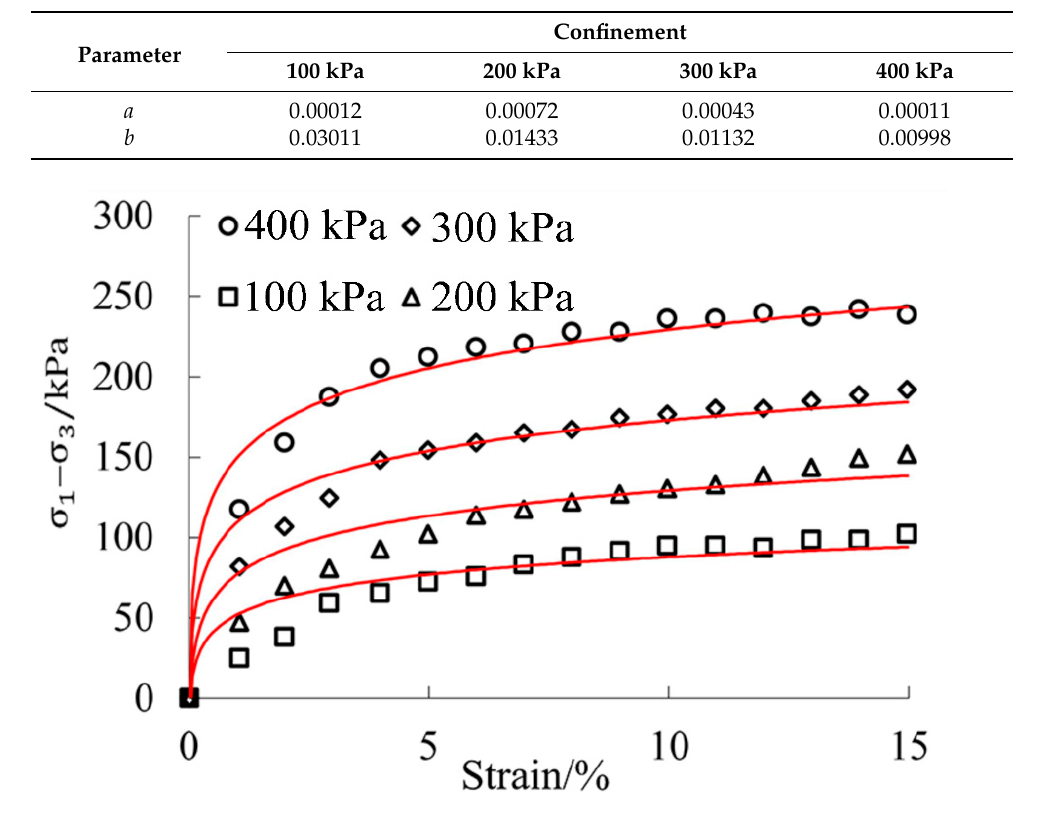
Table 5. Parameters of Duncan–Chang model.